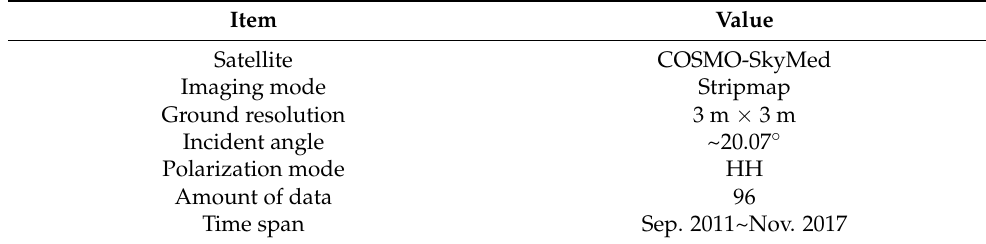
Table 1. Basic parameters of InSAR data used in the study area.